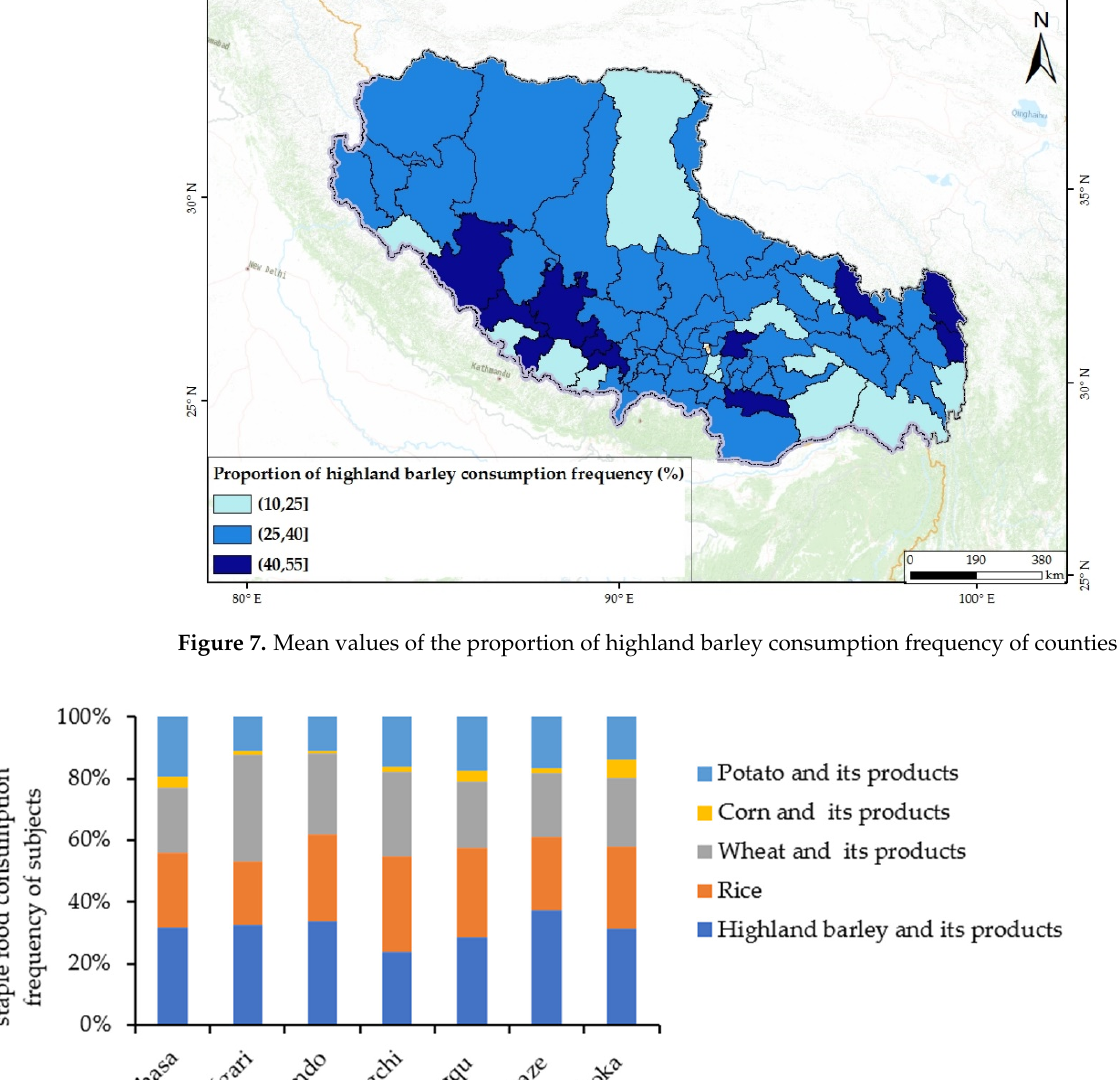
Figure 8. Mean values of the proportion of staple food consumption frequency of subjects in cities in Tibet.